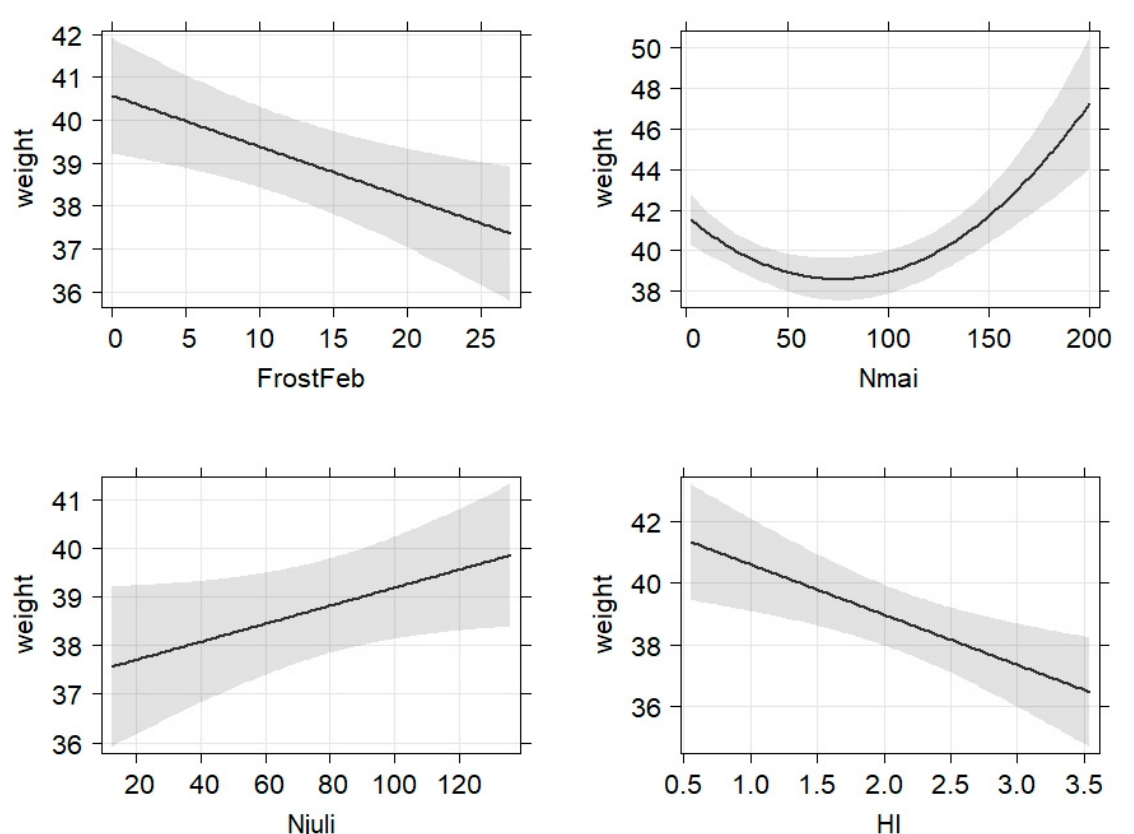
Figure 4. Bw (weight) of wild boar females of all ages was negatively influenced by days of frost in February (FrostFeb), lower precipitation in May (Nmai, precipitation in mm) and July (Njuli, precipitation in mm) and strong hunting pressure (HI, ratio of hunting bag/hunting area).